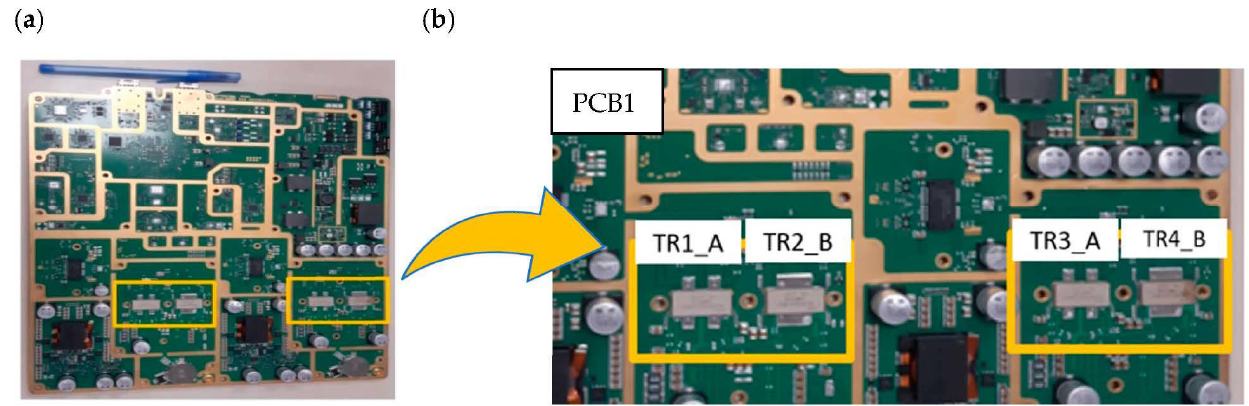
Figure 5. Arrangement of the measured transistors on the tested PCBs ( a ) and the zoom of this PCB ( b ).